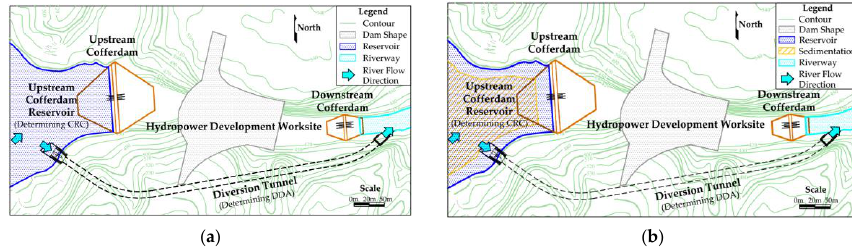
Figure 1. Typical construction diversion system under two conditions. ( a ) The clear-water river condition case; ( b ) the sediment-rich river condition case.